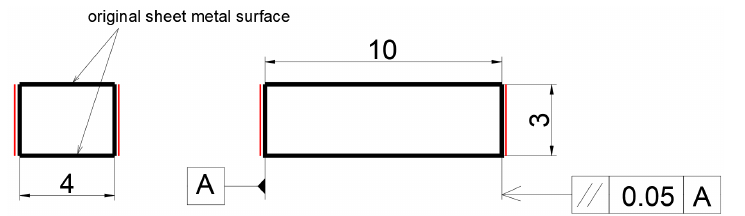
Figure 2. The schematic shape of samples for the dilatometric test with red lines indicating the machined sides.